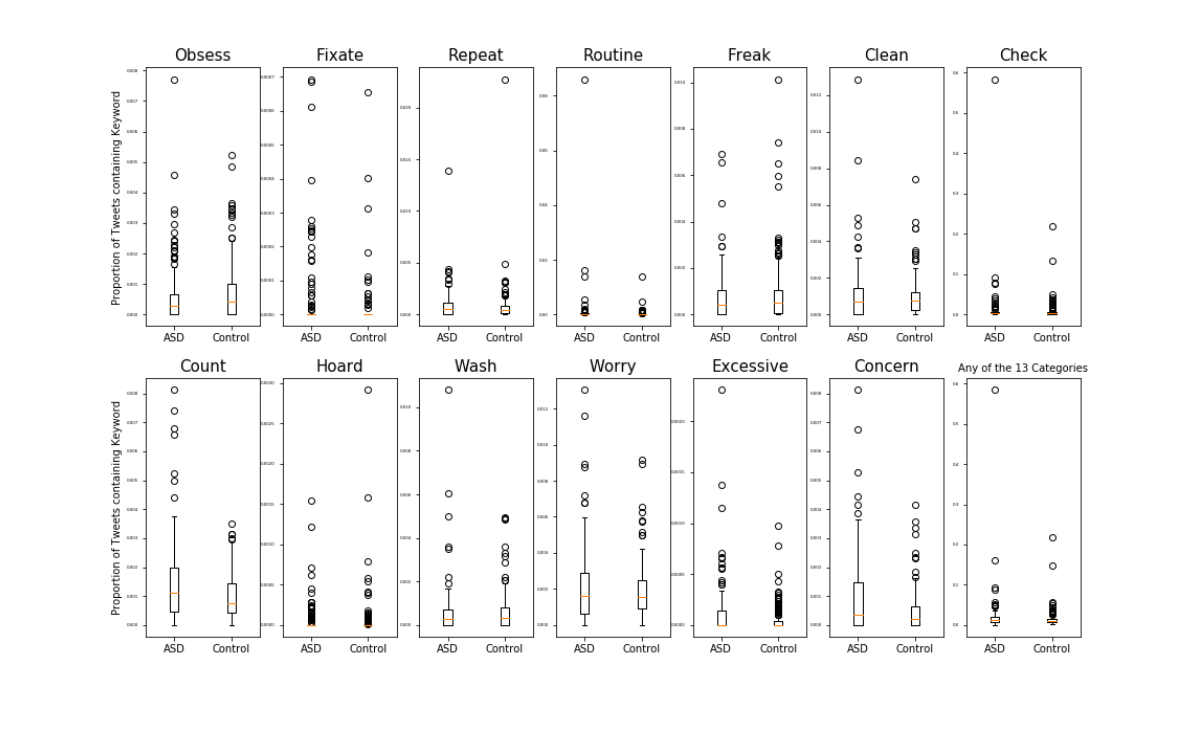
Among control twitter usersAmong twitter users with ASD